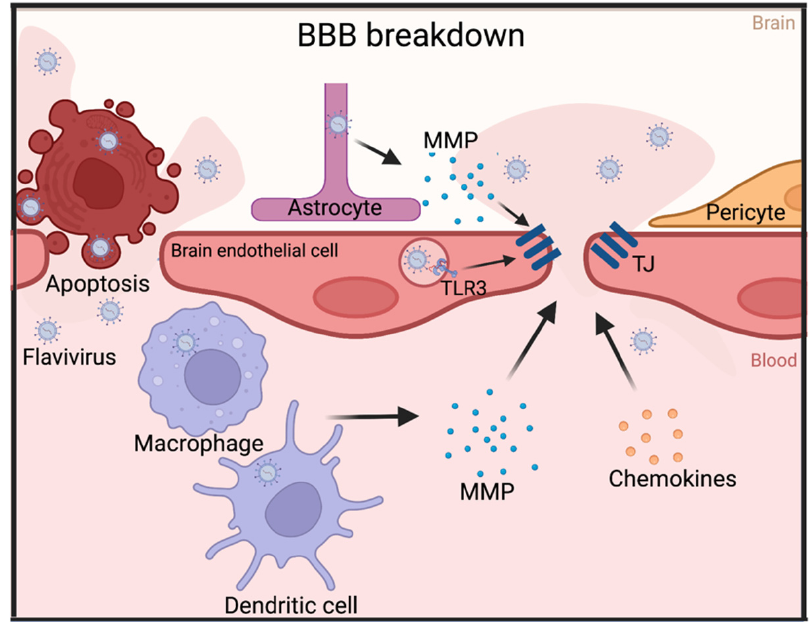
Figure 1. Mechanisms of BBB breakdown. Diagram demonstrating several mechanisms by which flaviviruses can induce the permeability of the blood–brain barrier. Abbreviations: MMP = matrix metallo proteases, TLR3 = Toll-like receptor 3. Made in Biorender.